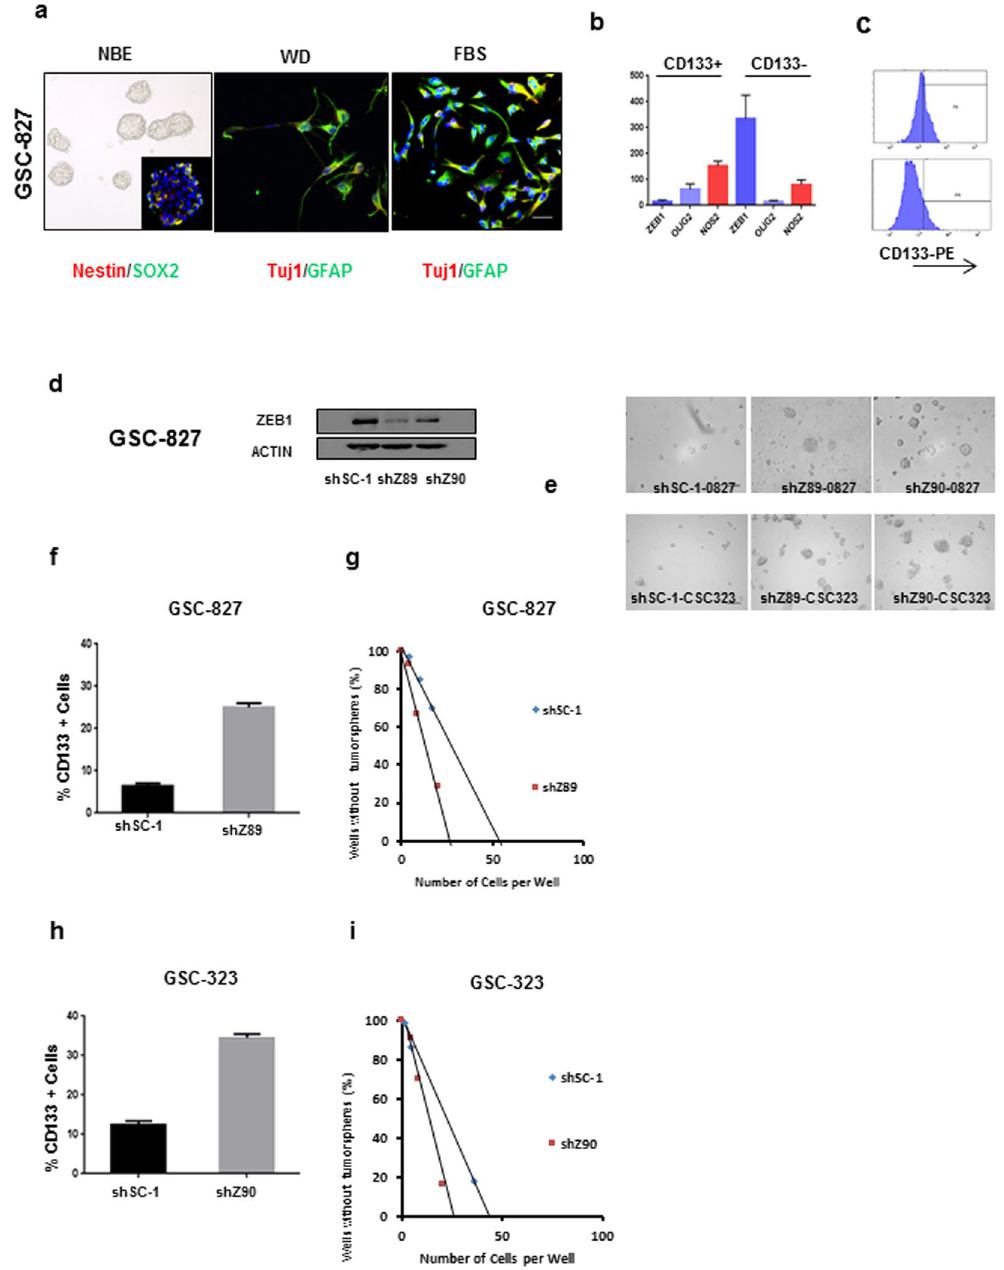
Figure 4. ZEB1 loss enhances stemness in GCSCs. ( a ) Left, GCSCs forming neurospheres and expressing Nestin and Sox2. Middle, Right, GCSCs induced to differentiate expressing TUJ1 and GFAP. NBE = Neural Basal A media, WD = growth factor withdrawal, FBS = fetal bovine serum. Scale bar represents 100 μ m ( b ) real time qRT-PCR expression of ZEB1, OLIG2 and NOS2 in enriched CD133 GCSCs (wildtype ZEB1) and matched CD133 depleted GCSCs. ( c ) Top panel, Flow cytometry of GCSCs indicates CD133 positivity in contrast to GCSCs that were cultured under differentiation conditions that do not. ( d ) Western blot indicating GCSC 827 ZEB1 knockdown with shRNA targeting ZEB1 (shZ89, shZ90) or a non-targeting scrambled control (shSC-1, top western right). ( e ) Neurosphere morphology of GCSCs targeted with either ZEB1 shRNAs (shZ89, shZ90) or non-targeting shRNAs (shSC-1). (f) The percentage of CD133 + 827 GCSCs targeted with either ZEB1 targeted shRNAs (shZ89 or shZ90) or non-targeting shRNAs (shSC-1) were determined by flow cytometry. (g) Limiting dilution sphere-forming assay indicated that cells transduced with shRNAs targeting ZEB1 (shZ89 or shZ90) increased self-renewal in vitro . (h,i) Same as (f,g) only 0323 GCSCs were ZEB1 represses LIF expression in GCSCs. Through our analysis of GBMs for copy number we also looked at gene expression and found that a strong negative correlation was apparent between ZEB1 and LIF (Fig. 6e), a known regulator of stem cell self-renewal in gliomas 31 . Given that ZEB1 is also known to have